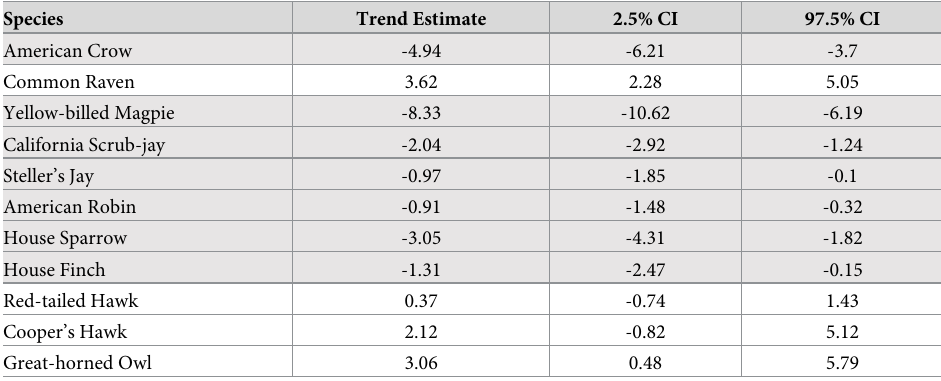
Table 7. Breeding Bird Survey adjusted count trends: Relative abundance change (%) per year in California, 2004–2019. Unshaded species displayed an increase or no change; shaded species a